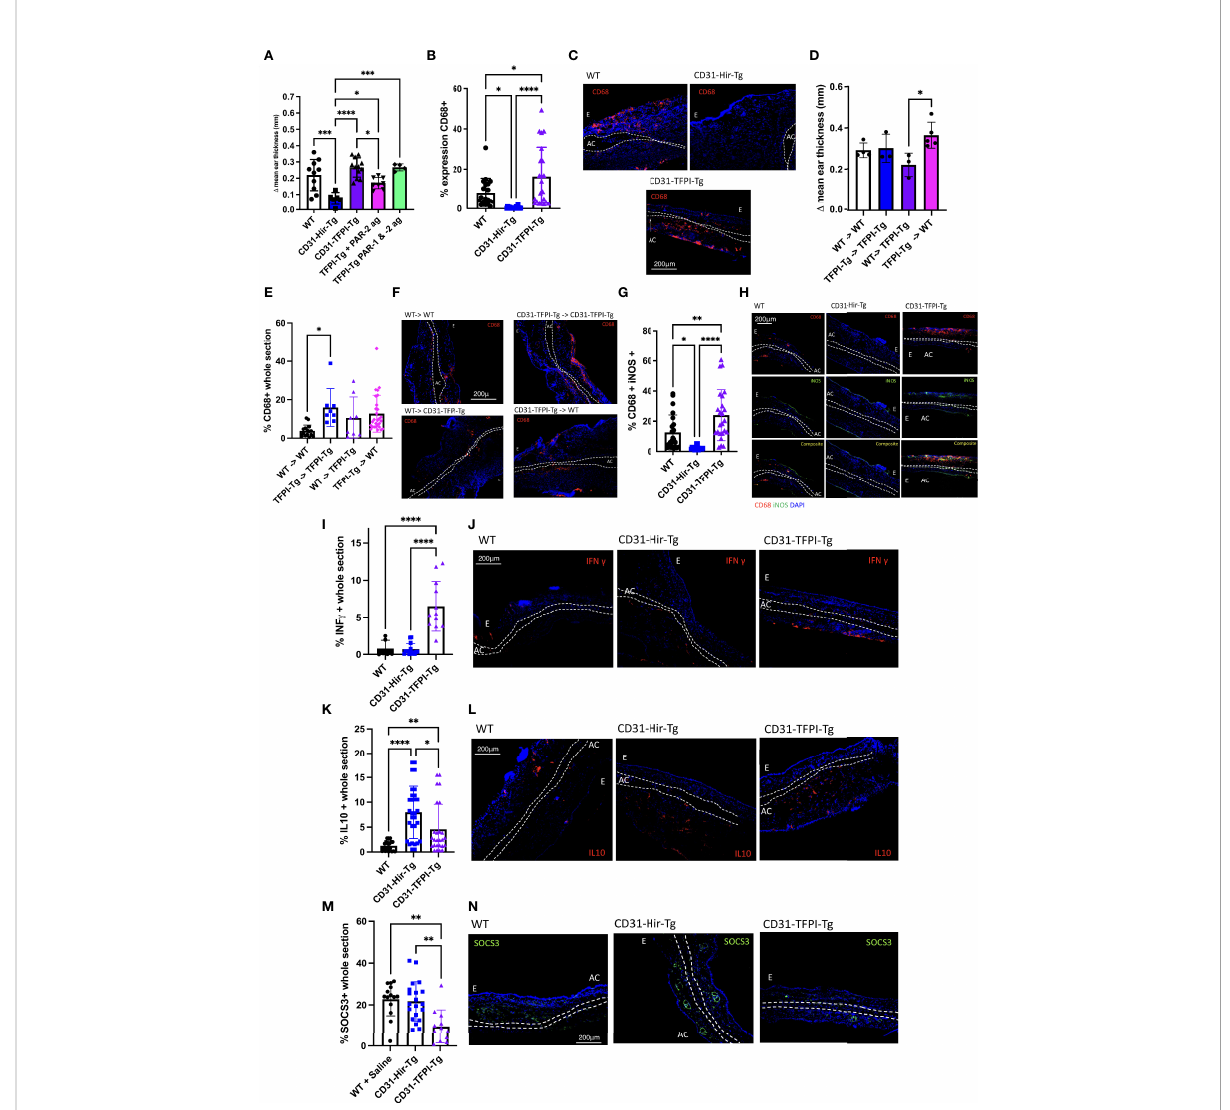
FIGURE 4 Complete inhibition of TF-mediated PAR signalling on myeloid cells enhances delayed type hypersensitivity responses by removing basal PAR-2 signaling. (A). The outcomes of oxazolone induced DTH at 24 hours in C57BL/6 (WT) (white bar n=10), CD31-Hir-Tg (blue bar) (n=6), CD31- TFPI-Tg mice (purple bar) (n=9), CD31-TFPI-Tg mice given 10microM/g PAR-2 agonist (2-Furoyl-LIGRLO-amide) (pink bar) (n=8) and CD31- TFPI-Tg mice given 10microM/g PAR-1 agonist (SFLLR-NH2) and PAR-2 agonist (2-Furoyl-LIGRLO-amide) (green bar) (n=4). The PAR